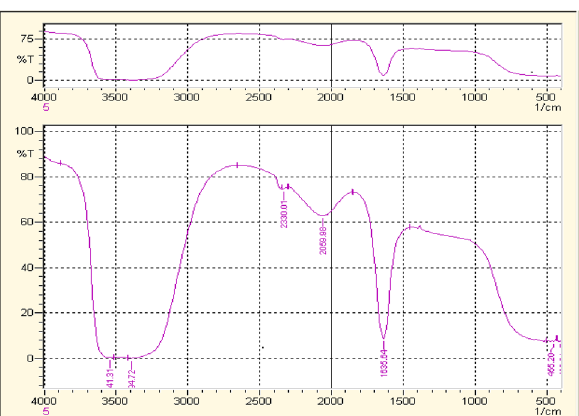
Figure 4: Temperature e ff ect of aqueous nanoparticles of Tropaeolum majus .